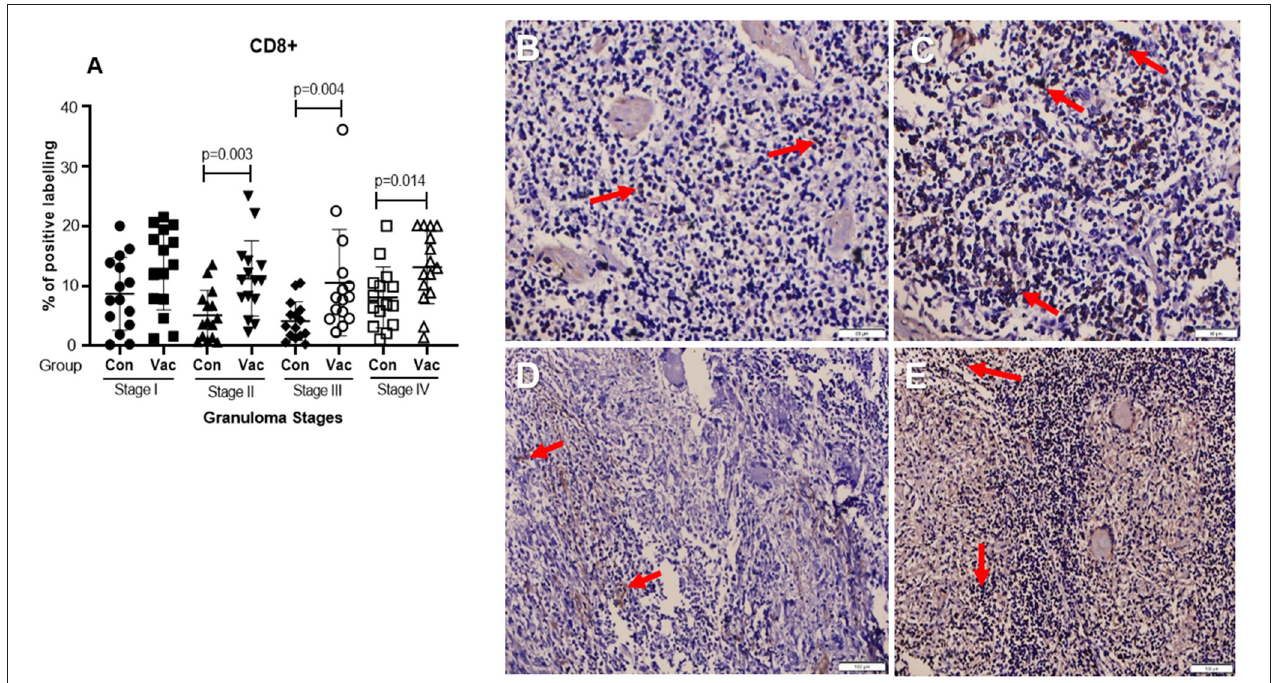
FIGURE 2 | Immunolabelling for CD8 + cells (ABC IHC stain, DAB brown chromogen). (A) Comparison of CD8 + cell distribution in different granuloma stages of BCG vaccinated (Vac) and non-vaccinated (Con) calves. (B) Stage I granuloma from non-vaccinated calf showing very few stained CD8 + cells (arrows). (C) Stage I granuloma from BCG vaccinated calf showing stained CD8 + cells (arrows). (D) Stage III granuloma from non-vaccinated calf showing few stained CD8 + cells (arrows). (E) Stage III granuloma from vaccinated calf showing abundance of CD8 + cells (arrows). Bar equals 50 µ m in (B,C) and 100 µ m in (D,E)